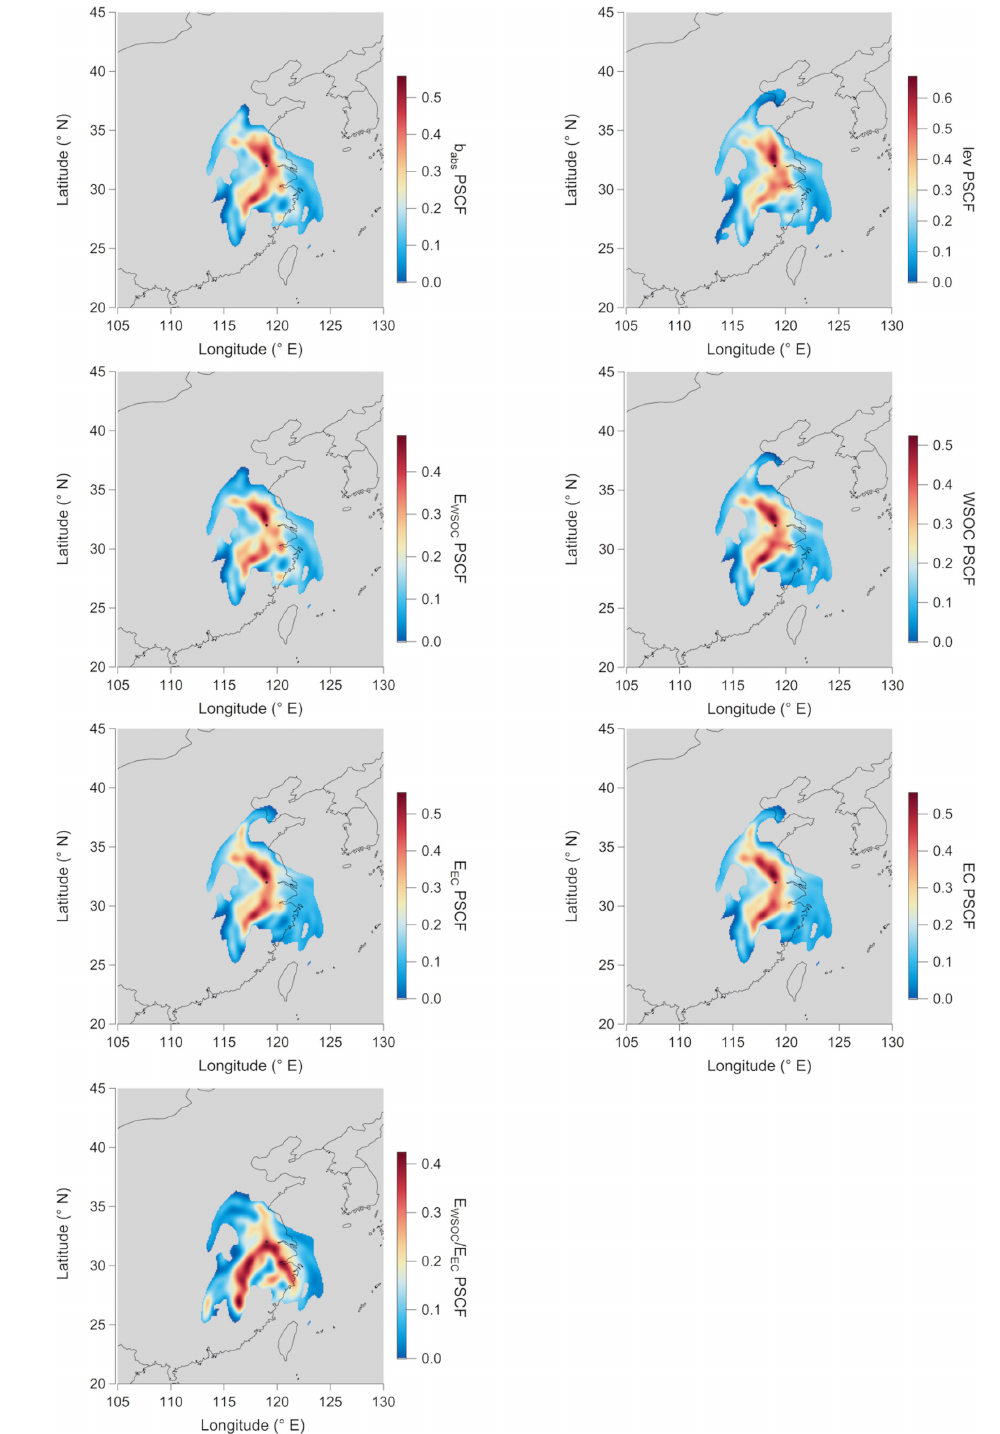
Figure 12. The PSCF map for levoglucosan (lev), water-soluble BrC absorption coefficient ( b abs ), WSOC, EC, light absorption of WSOC ( E WSOC ) and EC ( E EC ) and the WSOC to EC light-absorption ratio ( E WSOC /E EC ) for PM 2 . 5 from 14 to 29 January 2015 in Nanjing (black